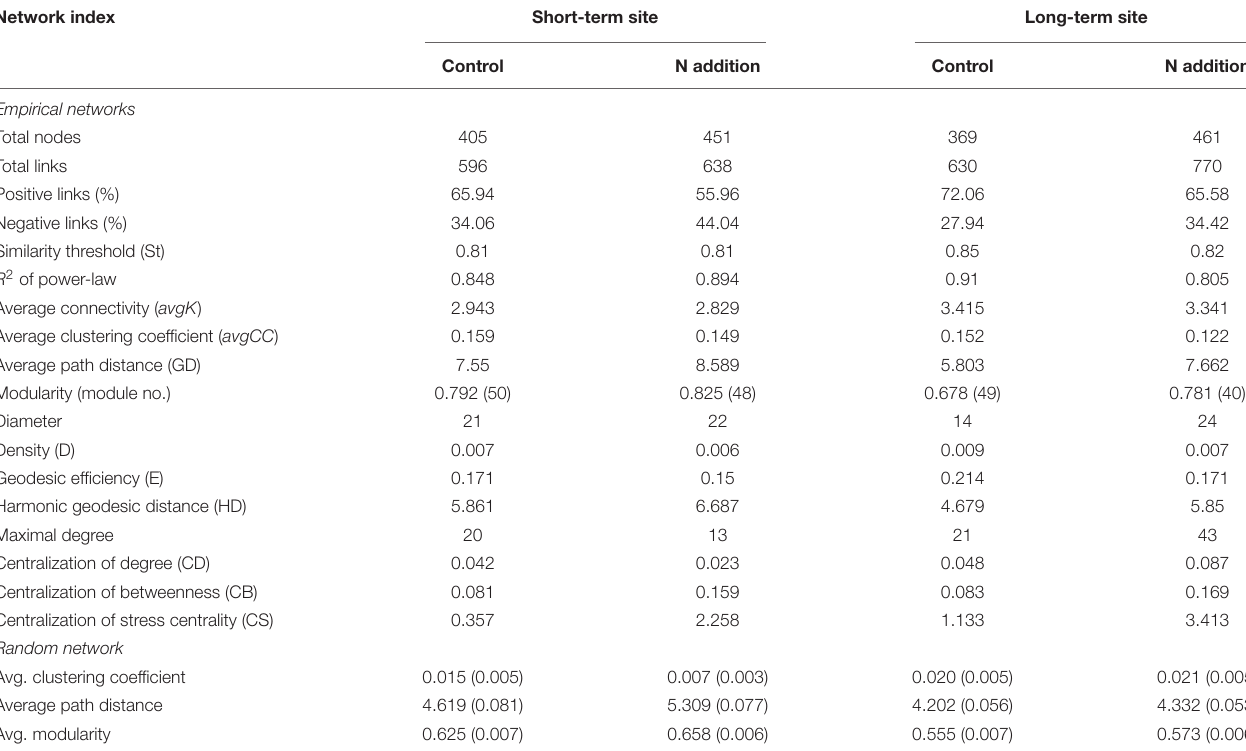
TABLE 1 | Detailed topological properties of the empirical and random networks of fungal community in soils under control and N addition at the short- and long-term sites,